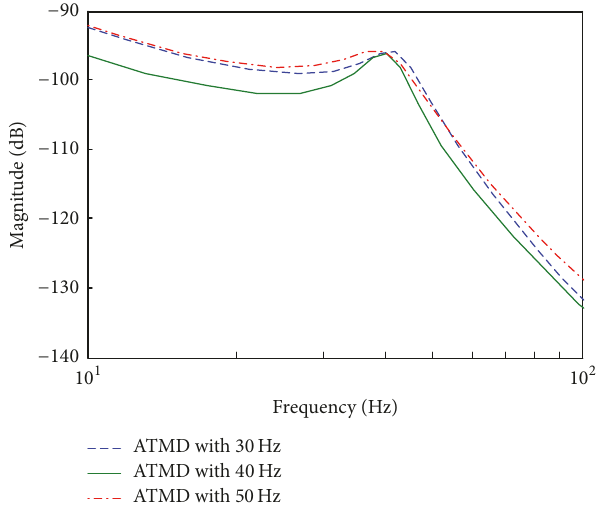
Figure 8: Stroke of the ATMDs for different natural